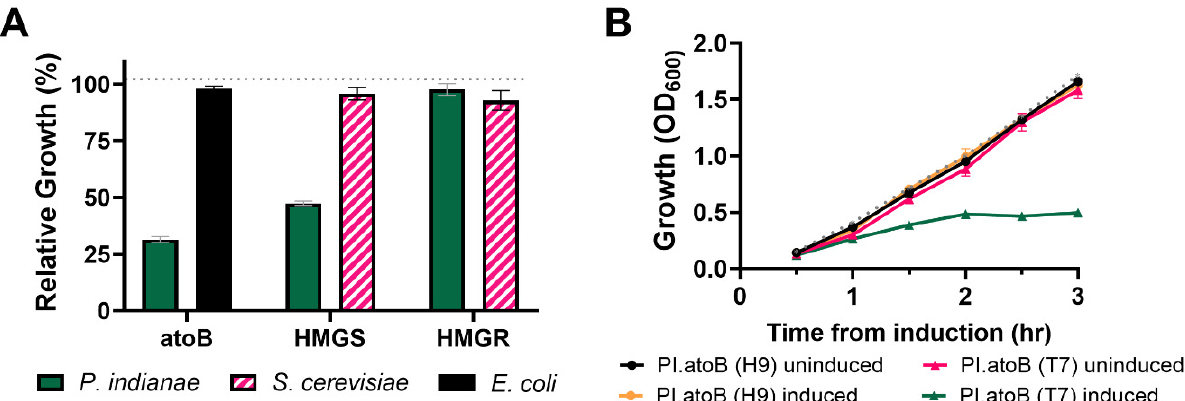
Figure 4. Relative growth of E. coli expressing the E. coli , S. cerevisiae , or P. indianae homologs. ( A ) Relative growth of E. coli BL21 when expressing individual genes of the mevalonate pathway under an inducible T7 promoter. ( B ) Growth curve of E.coli BL21 expressing the PI.atoB under the T7 promoter and a weaker H9 promoter variant. Growth is relativized to the growth of an uninduced control for each homolog. Relative growth is calculated by taking the final OD 600 of the induced gene divided by the final OD 600 of the uninduced gene. The T7-mCherry expression control is indicated by a dotted gray line in both panels A & B. Error bars represent standard deviation; n = 3 for all